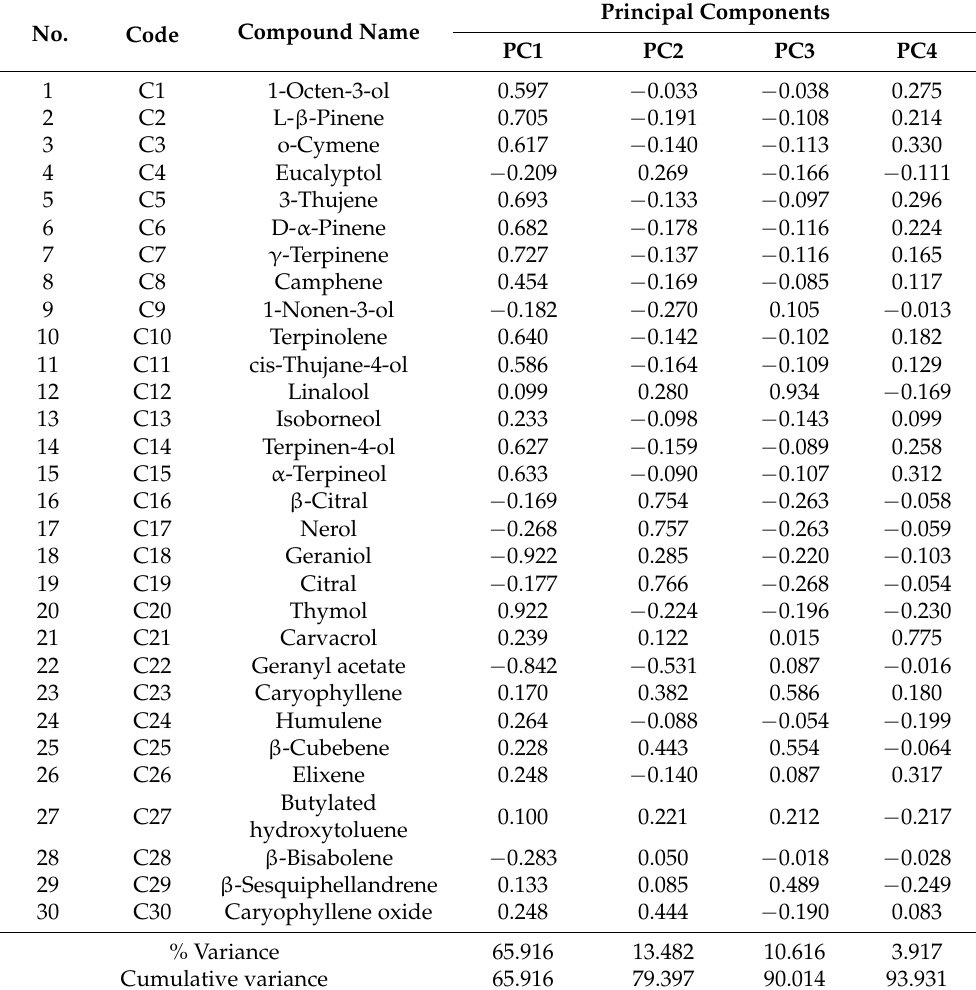
Table 4. Principal component scores of the essential oil components in T. quinquecostatus populations.